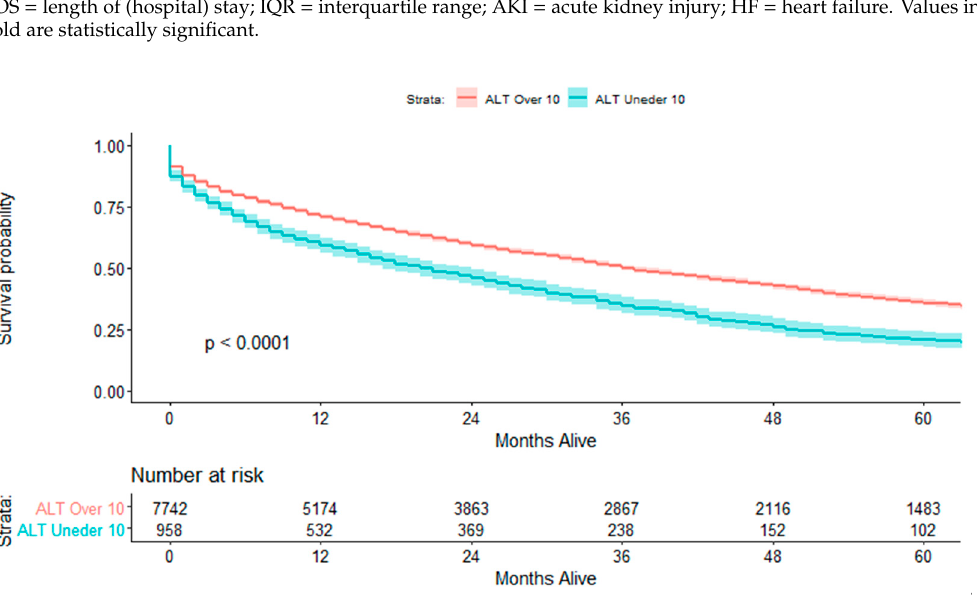
Figure 2. Survival according to baseline ALT level.